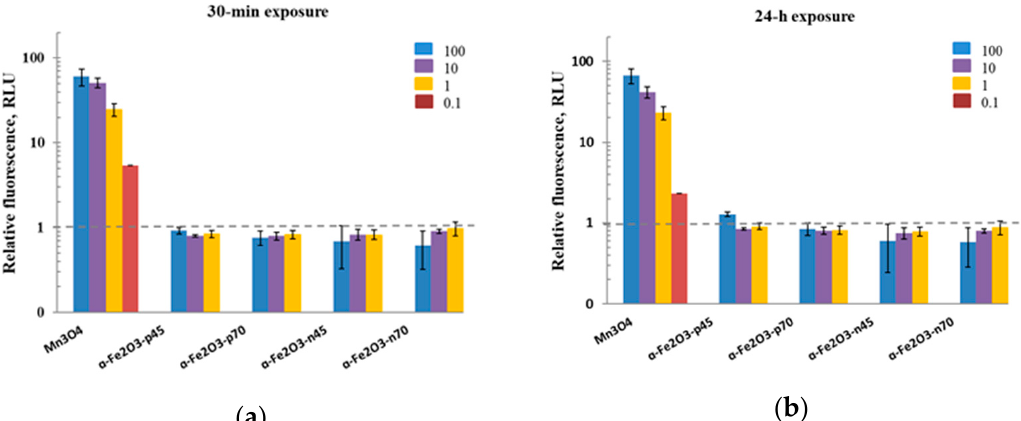
Figure 9. Generation of reactive oxygen species (ROS) measured with fluorescent dye DCF-DA in abiotic conditions (i.e., without of the cells) after 30 min ( a ) and 24 h ( b ) exposure to hematite NPs (1–100 mg/L), and Mn 3 O 4 NPs—a positive control (0.1–100 mg/L)—in DI water. The values are presented as fold-increase in fluorescence in the presence of the NPs compared to the control (DI water); the mean of 4 experiments is given ± SD. All exposure concentrations are nominal. The dashed horizontal line indicates the ROS level in the DI water.